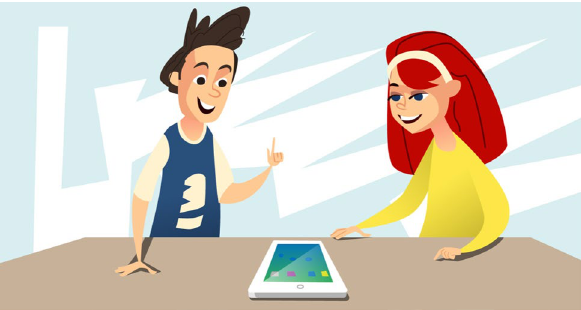
About the Authors About the